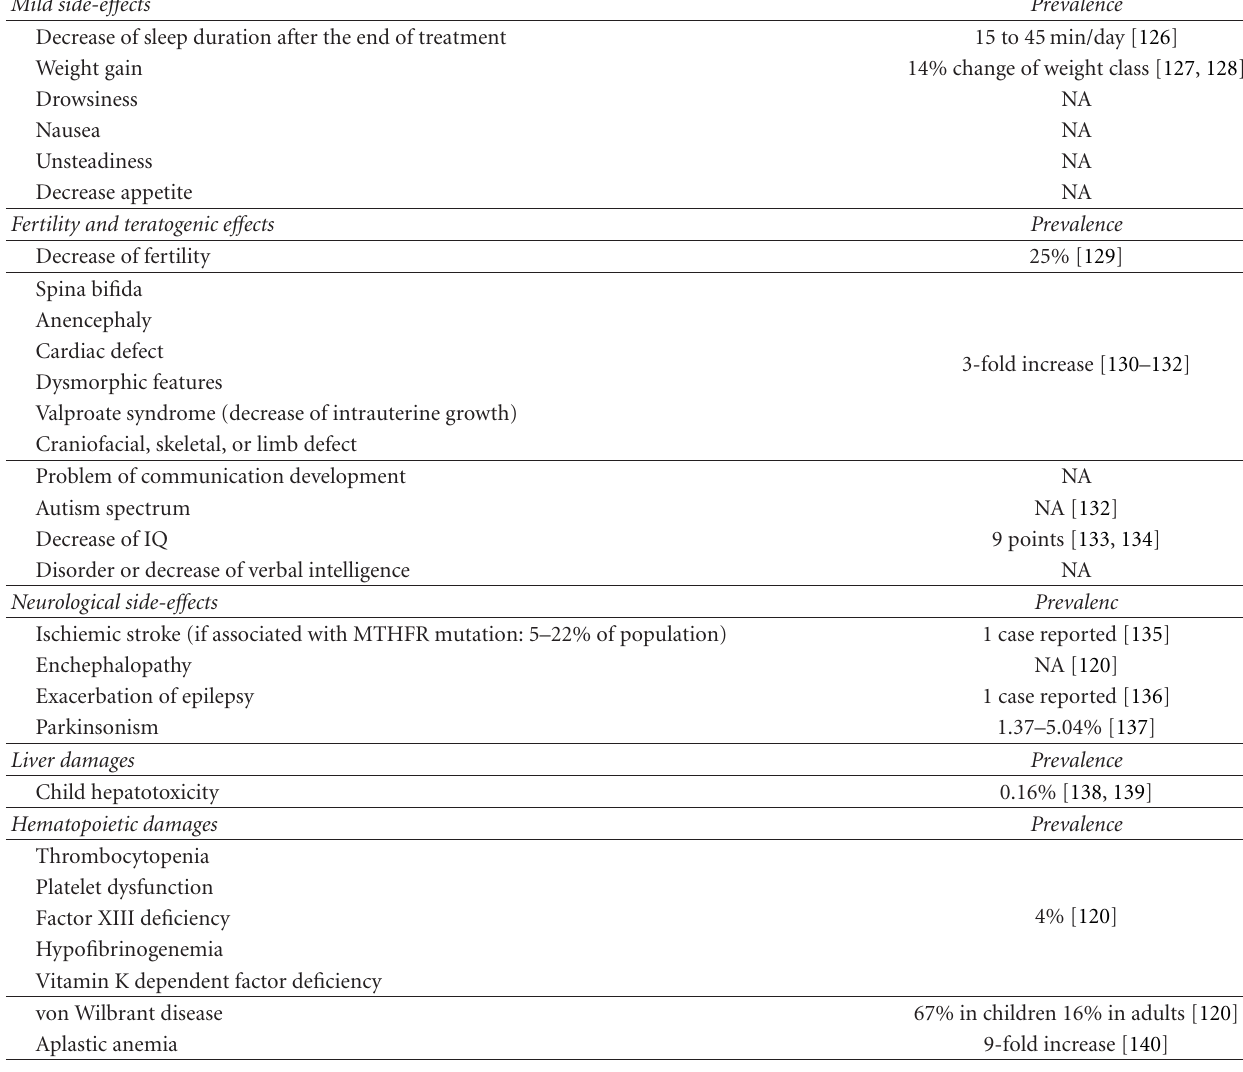
Table 2: Side e ff ects and prevalence . List of classified side e ff ects observed during treatment with VPA. NA: Data not